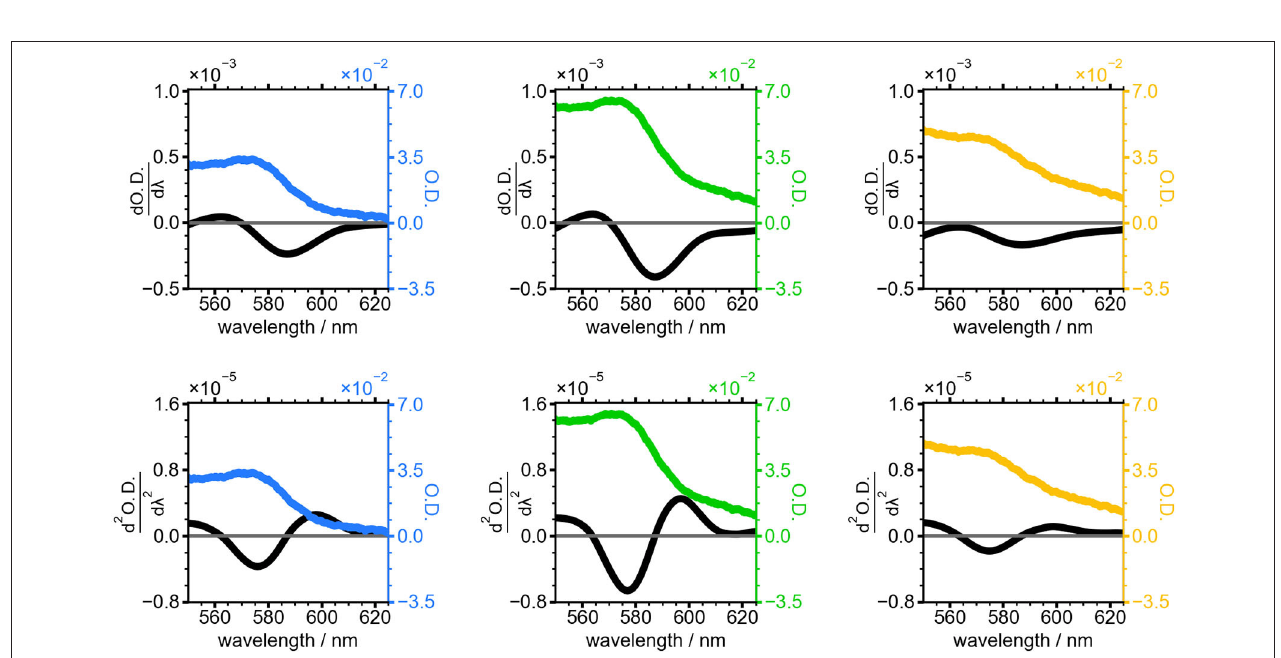
FIGURE 5 | Absorbance spectra of NCs grown for 20 min (blue), 30 min (green), and 50 min (yellow). First (top) and second (bottom) derivative of the absorbance spectrum for each time point is shown in black.